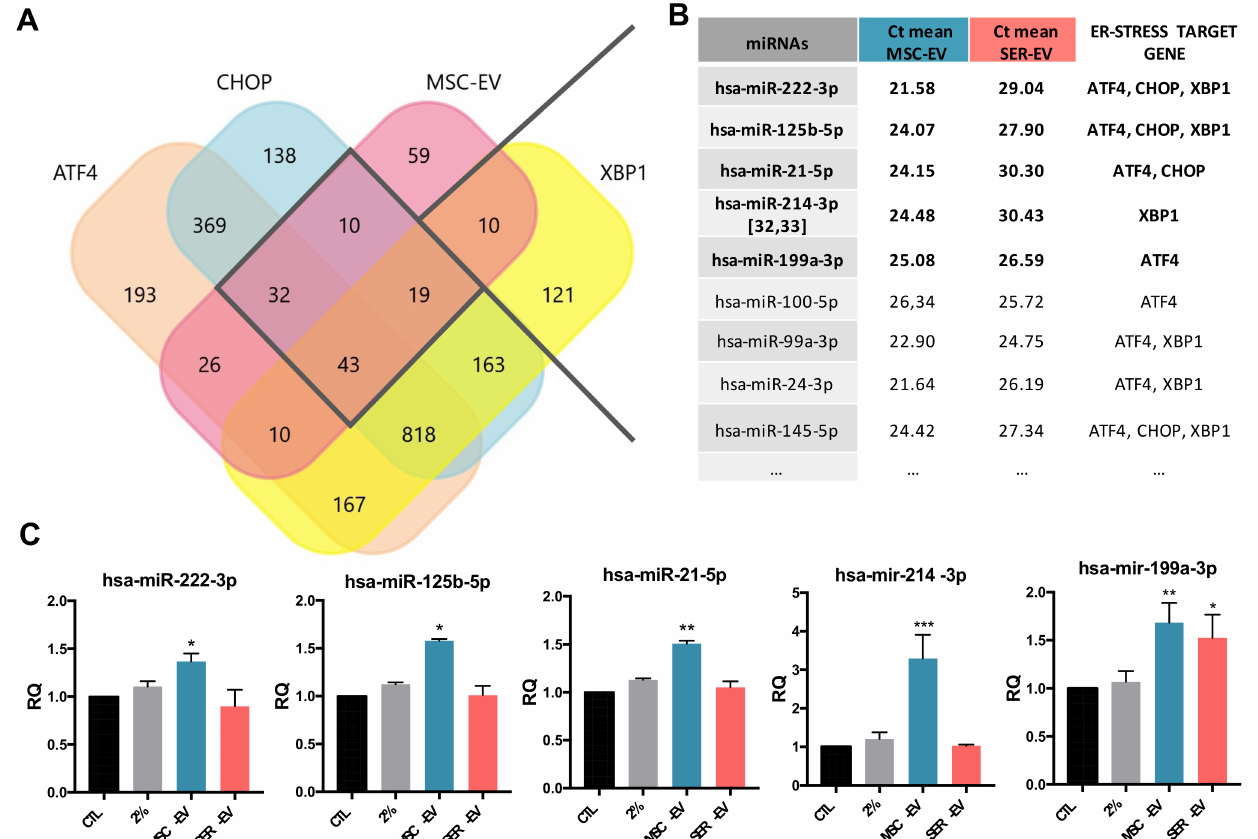
Figure 7. Target miRNAs prediction of MSC-EVs and ER stress related genes. ( A ) Representative Venn diagram showing the numbers of the target miRNAs predicted for CHOP, ATF4, and XBP1, and those described in the literature for MSC-EVs [30]. The numbers displayed in the diagram represent the number of miRNAs that were found to target the indicated transcripts. ( B ) Table showing the miRNAs and Ct means of the most expressed miRNAs in MSC-EVs [29], compared with the Ct values of the same miRNAs in the SER-EVs [31]. Data are displayed as the mean CT value. The ER stress target gene column highlights the target genes of each miRNA among the genes used (ATF4, CHOP, and XBP1). ( C ) Real time PCR analysis of miRNAs transferred by MSC-EVs in HCECs. HCECs were treated with EVs in the presence of amanitin (50 µ g/mL). CTL—HCECs in normal medium; 2%—HCECs in serum deprivation; MSC-EVs and SER-EVs—HCECs treated with MSC-EVs and SER-EVs (20 × 10 3 EV/cell), respectively. RNU6B was used as the endogenous normalizer. Data were further normalized to CTL, set as 1, and used as reference sample for each experiment. The graphs show the RQ average (2 − ∆∆ Ct ) of at least three independent experiments ± SD. One-way ANOVA with Tukey’s multiple comparisons test was performed after the normalization of each experiment to CTL; * p < 0.05 vs. CTL, ** p < 0.001 vs. CTL, *** p < 0.0001 vs.